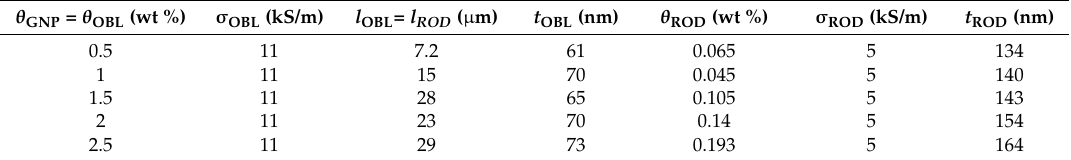
Table 2. Estimated fitting parameters of the MMG model applied to the measured complex effective permittivity of the vinyl ester-based composites produced in this study, as a function of the weight concentration of GNPs θ GNP